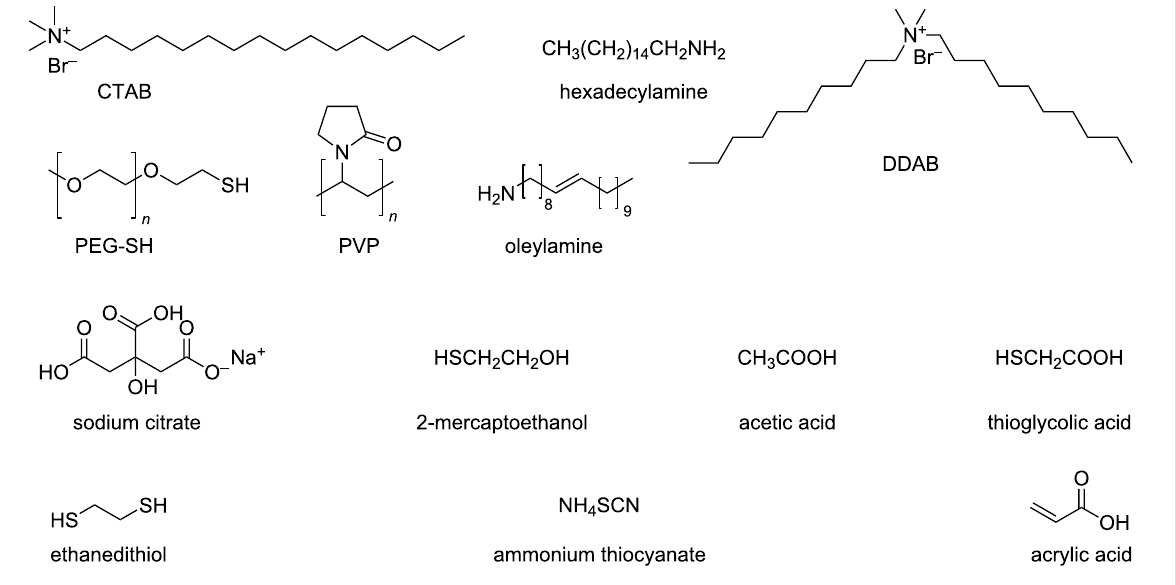
Figure 2: Common surface ligands for solution metal particle synthesis and ligand exchange. They provide colloidal stability to gold, silver, and copper